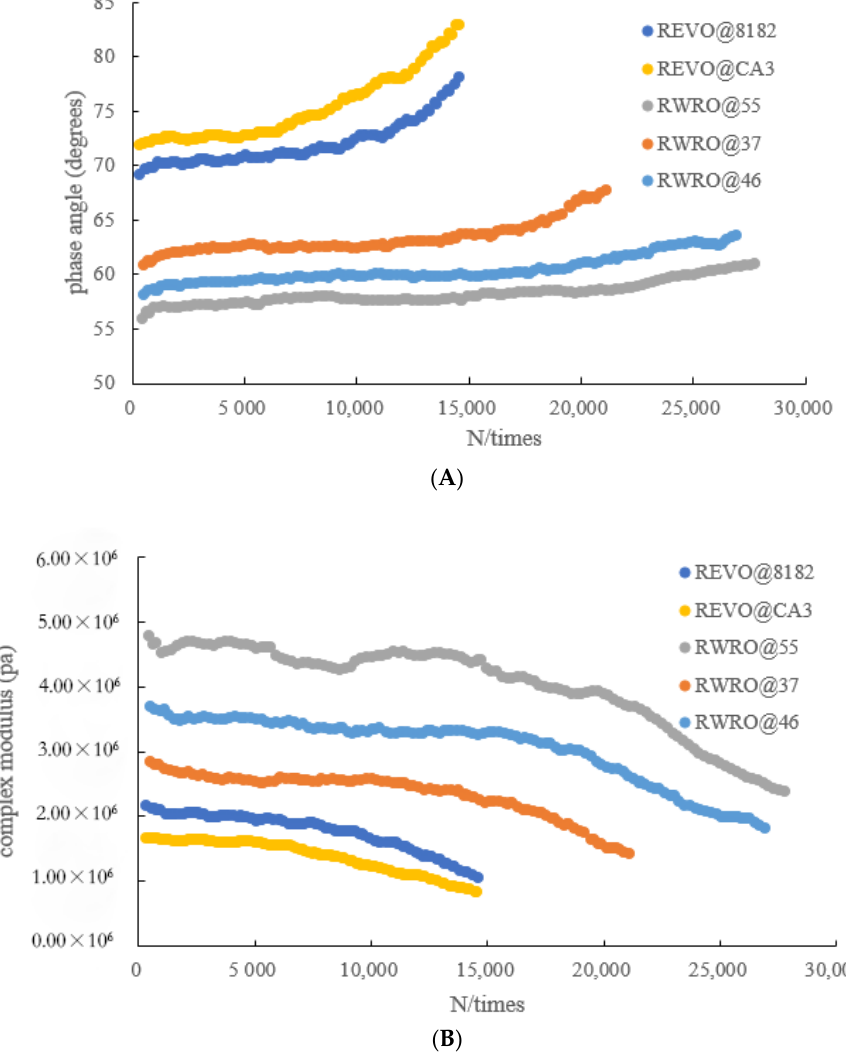
Figure 12. ( A ) Relationship between phase angle and loading times. ( B ) Relationship between phase angle and loading times.